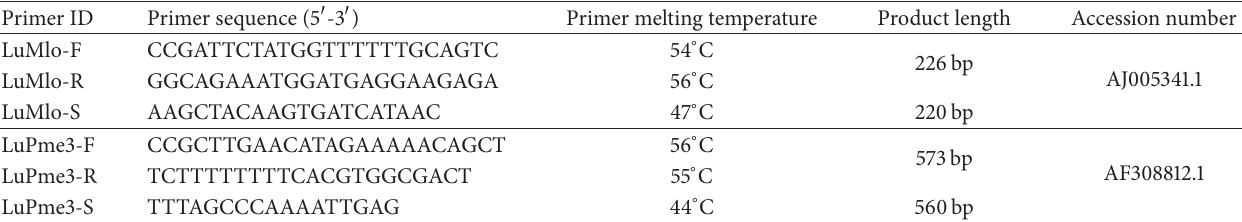
Table 1: Sequence characteristics of primers developed in this study. PCR and sequencing primers were designed for amplification the gene regions of Pme3 and Mlo